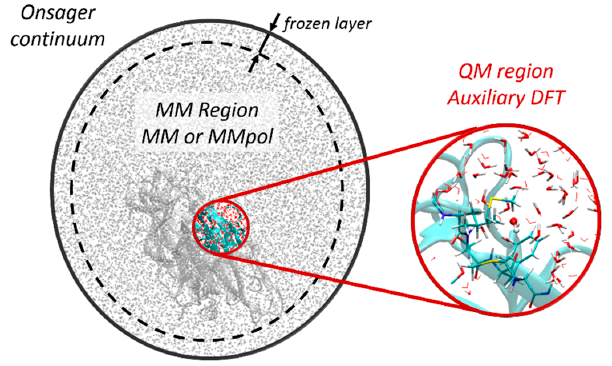
Figure1. ArecommendedpartitionforQuantumMechanical / MolecularMechanical(QM / MM) / Onsager Figure 1. A recommended partition for Quantum Mechanical/Molecular Mechanical simulations with (QM/MM)/Onsager simulations with deMon2k.